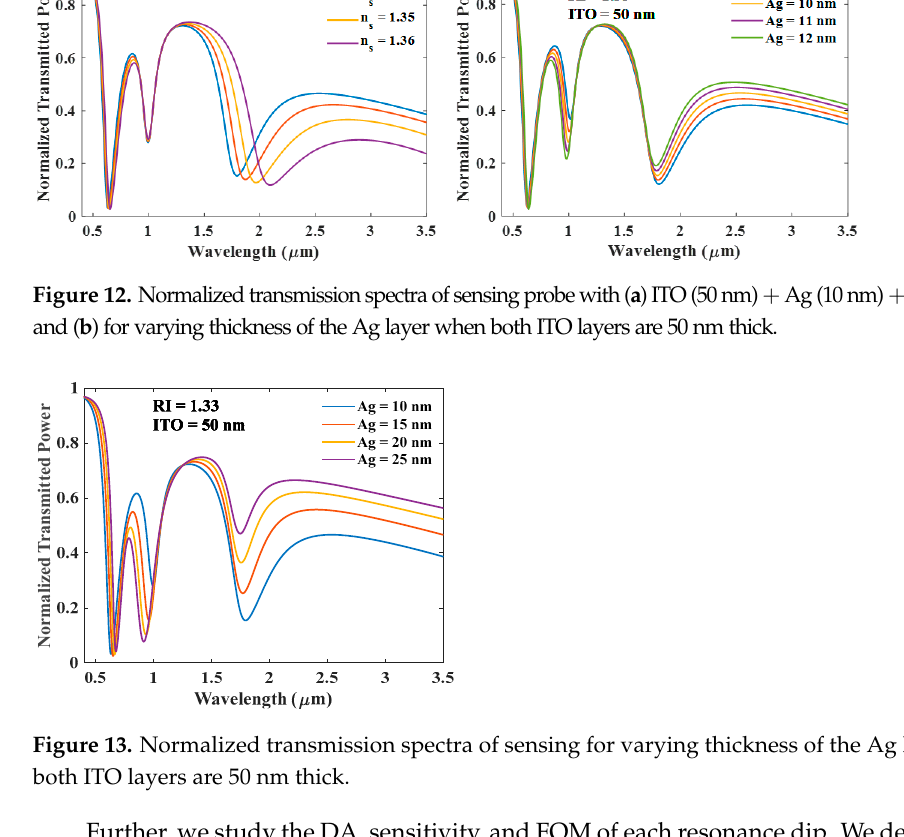
Figure 13. Normalized transmission spectra of sensing for varying thickness of the Ag layer when both ITO layers are 50 nm thick.